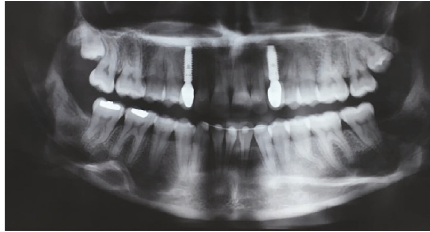
Figure 9: Panoramic image after two years of